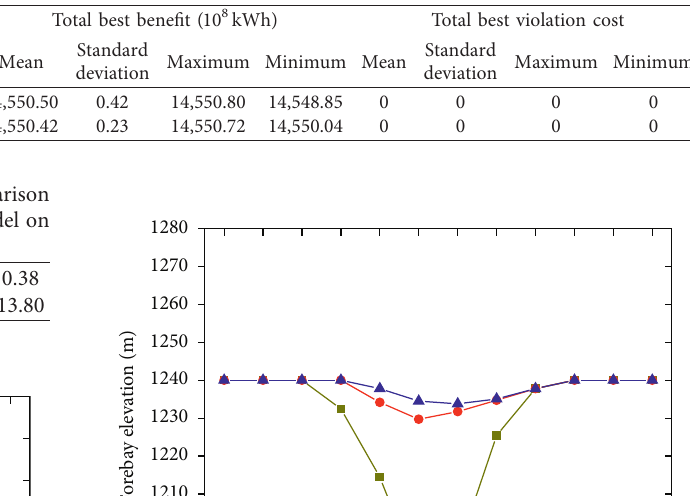
Table 5: Statistical execution time, total best benefit, and total best violation cost results of the sequentialization model and the coarse- grained multipopulation model on the case study.